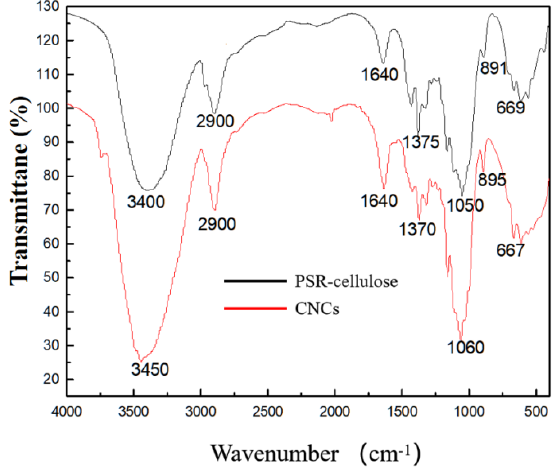
Figure 3. FTIR spectra of PSR-cellulose and